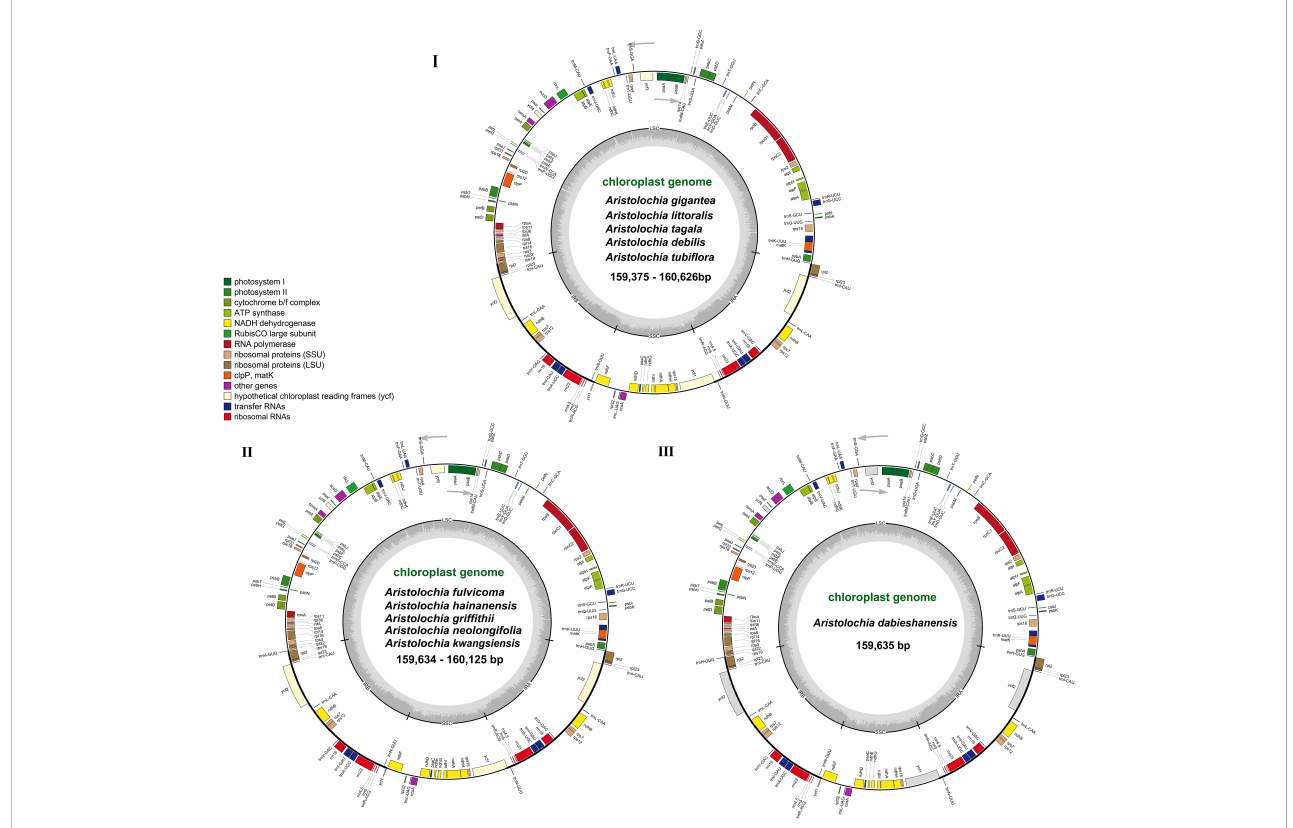
FIGURE 1 Gene maps of the complete cp genome of 11 species of Aristolochia. Three types of cp genome of (I) A. gigantea, A. littoralis, A. tagala, A. debilis and A. tubi fl ora . (II) A. fulvicoma, A. hainanensis, A. grif fi thii, A. neolongifolia and A. kwangsiensis . (III) A. dabieshanensis . Genes on the inside of the circle are transcribed clockwise, while those outside are transcribed counter clockwise. The darker gray in the inner circle corresponds to the GC content, whereas the lighter gray corresponds to AT